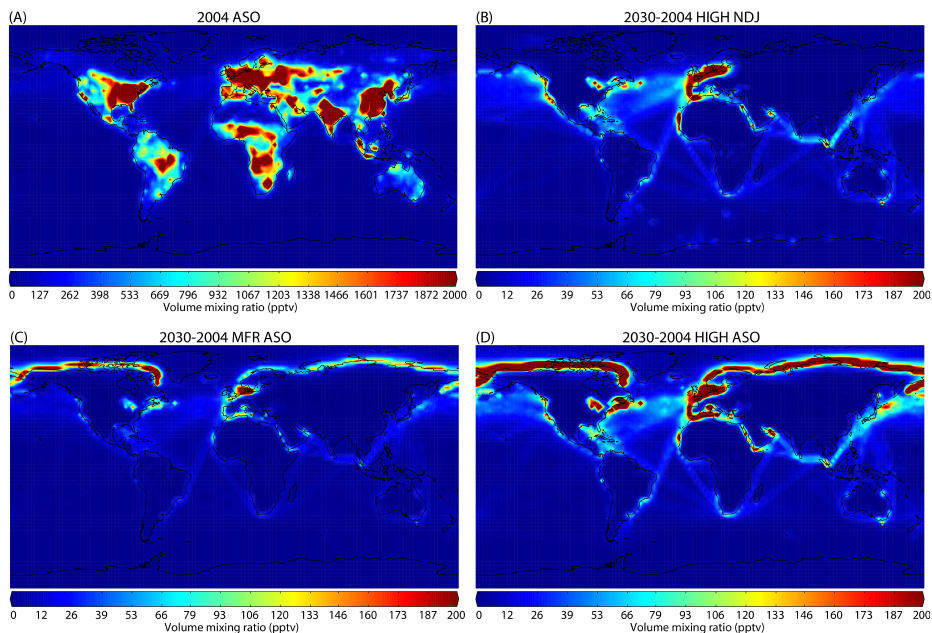
Fig. 1. NO 2 in the lowest model layer close to the surface (pptv). (A) Average 2004 for the months August-September-October (ASO). (B) Average change 2004–2030 for HIGH scenario for the months November-December-January (NDJ). (C) Same as (B) , MFR scenario, months ASO. (D) Same as (B) , HIGH scenario, months